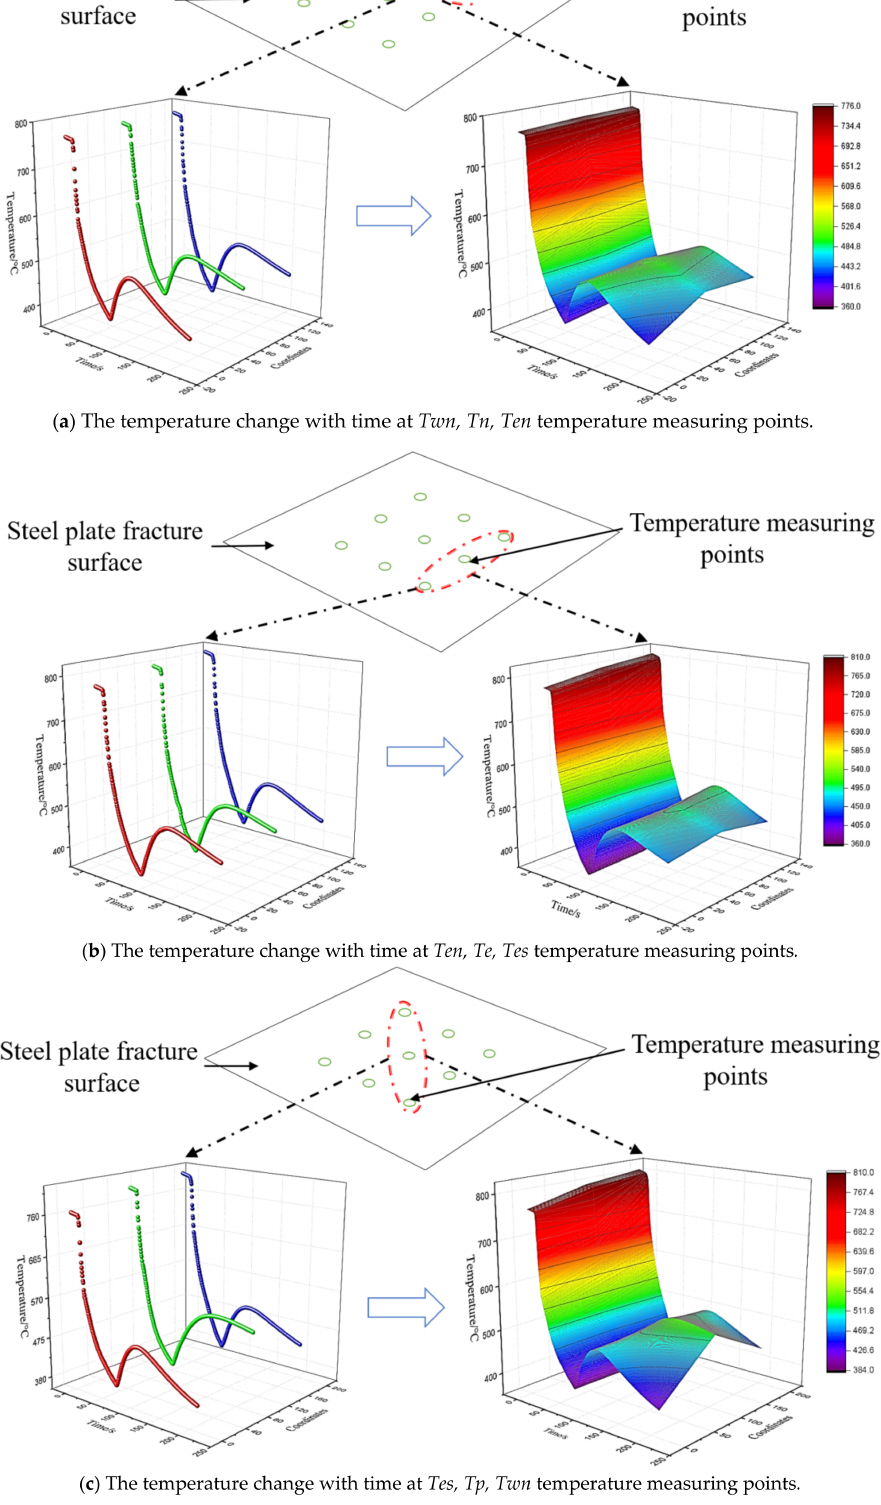
Figure 4. The temperature distribution rule of the three groups of temperature measuring points with